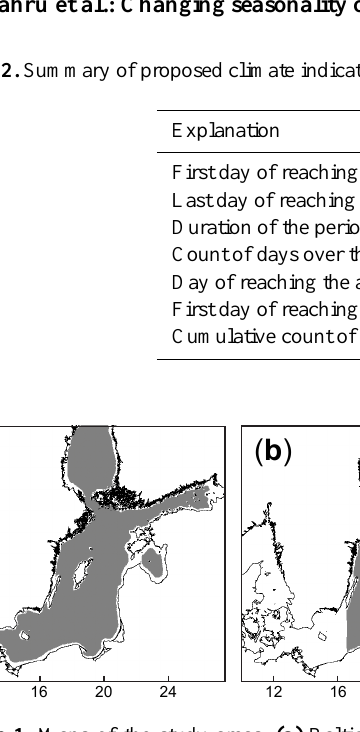
Figure 1. Maps of the study areas. (a) Baltic Sea area excluding shallow coastal areas and the Bothnian Bay (Kahru et al., 2007). (b) Central Baltic Sea including the following sub-basins: Northern Baltic Proper, Western and Eastern Gotland Basin and the South- eastern Baltic Proper. The shaded areas are used to calculate aver- ages for, respectively, Baltic and central Baltic Sea.